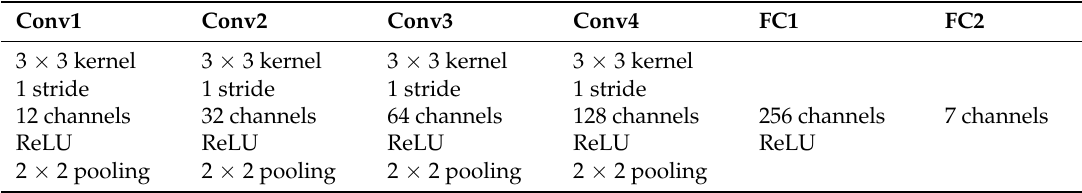
Table 2. Structure of the standard CNN deployed in the